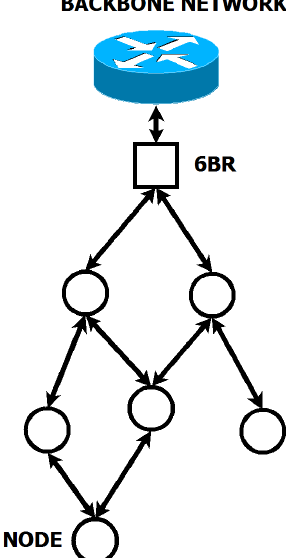
Figure 9. Architecture model of the IoT infrastructure. Detail of mesh area